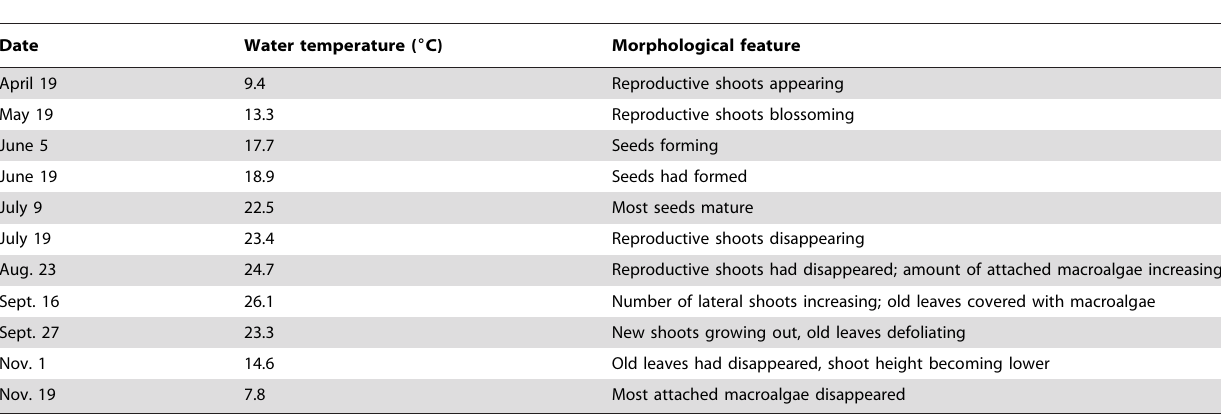
Table 1. Main morphological features of the transplanted Zostera marina monitored in 2012.